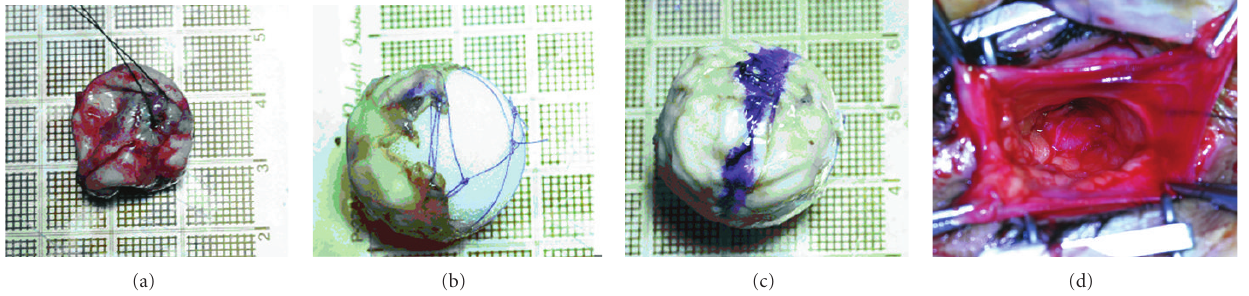
Figure 1: Phases of surgical preparation of the phthisis globe. (a) Enucleation of phthisis bulbous. A traction suture is placed on the cornea. (b) The sclera covers only the anterior surface of the porous implant; a mesh Vicryl suture maintains the sclera in a fixed position. (c) The sclera is longitudinally marked in blue color. (d) The posterior Tenon’s fascia is dissected to receive the